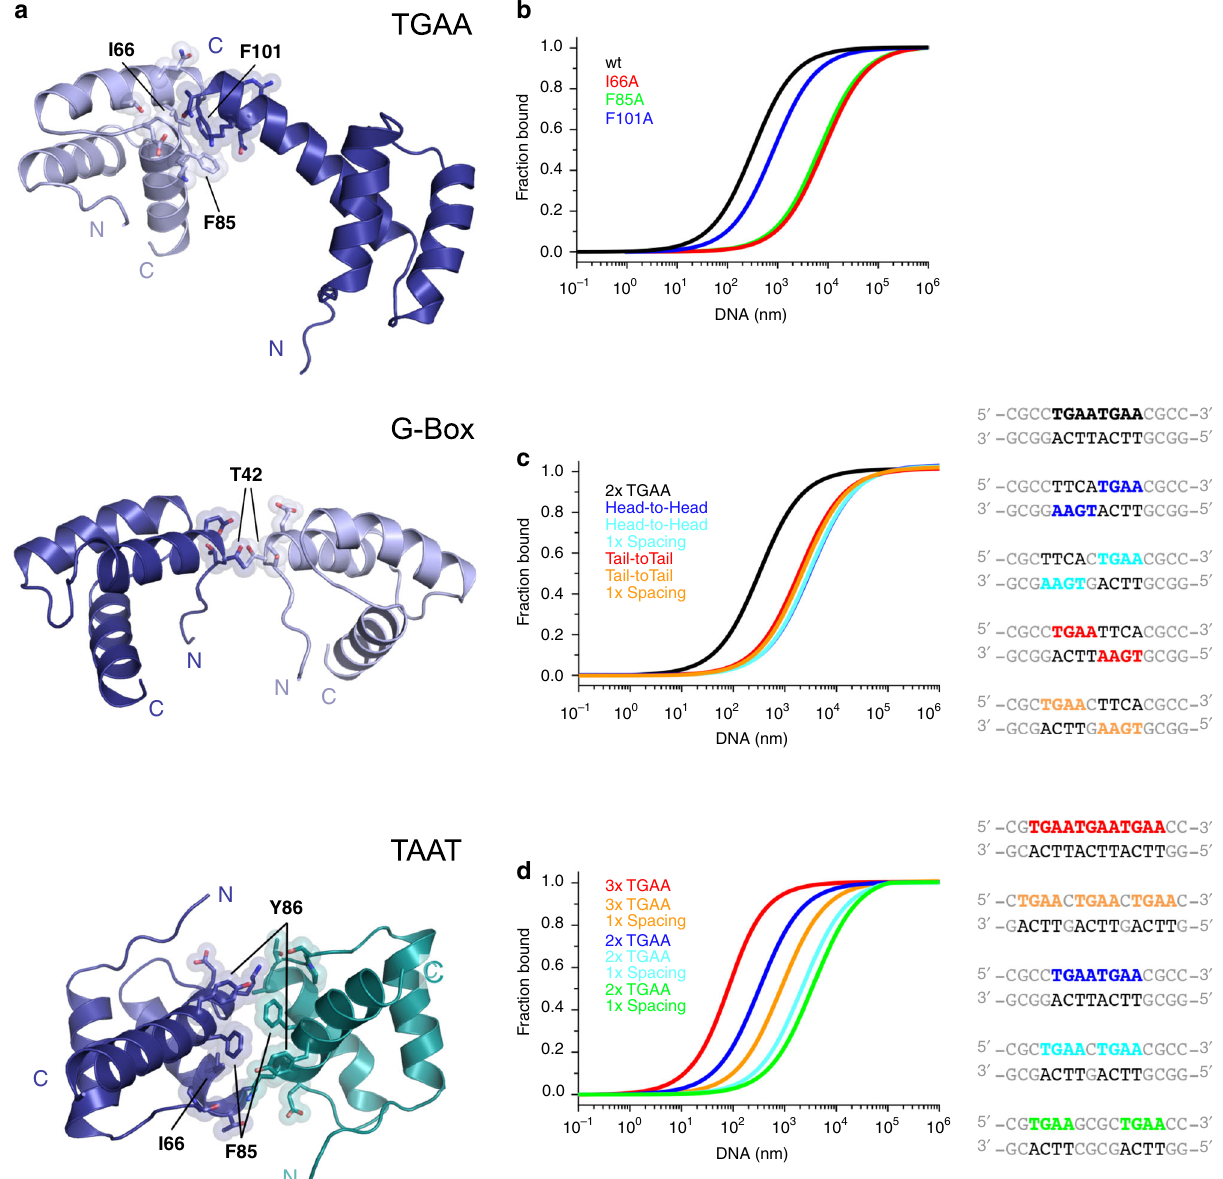
Fig. 5 DNA sequence speci fi city depends on WUS-HD dimerization. a DNA-facilitated protein interactions between individual HDs of WUS bound to TGAA (top), G-Box (center), and TAAT (bottom). For clarity DNA was omitted and side chains mediating the protein – protein interface are shown. Amino acids contributing most to the buried surface area are indicated and colors schemes are related to Fig. 2. b MST-analysis of the DNA-facilitated WUS dimerization interface. Single point mutants were introduced (I66A in red, F85A in green and F101A in blue) and binding was quanti fi ed for a 2xTGAA motif. c MST-analysis of orientation preferences for WUS binding toward different arrangements of a 2xTGAA DNA motif. The head-to-head arrangement is in blue and the tail-to-tail arrangement is in red, whilst the same arrangements with a 1 bp spacer are shown in cyan and orange, respectively. As a reference, the binding towards the tandem repeat 2xTGAA DNA motif is shown in black. d MST-analysis of spacing preferences for WUS DNA-binding activity. Binding af fi nity was measured for three TGAA recognition motifs (red) and with a 4 bp spacer (orange), and for two TGAA recognition motifs (blue), with a 1 bp spacer (cyan) and a 4 bp spacer